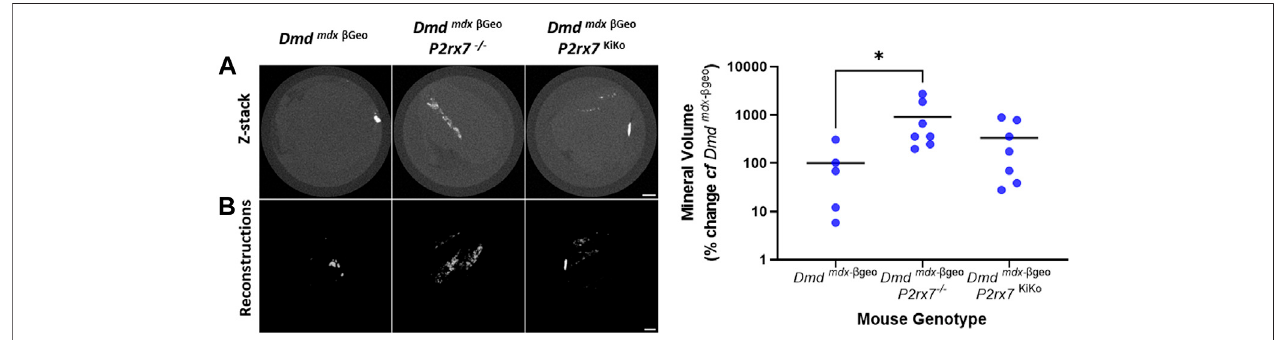
FIGURE3| Ectopicmineralisationin Dmd mdx- β Geo , Dmd mdx- β Geo P2rx7 − / − and Dmd mdx- β Geo P2rx7 KiKo quadriceps.Isolatedquadricepsmuscleswerescanned ex vivo by XCT and analysed in FIJI. (A) Z-stack images and 3D reconstructions from representative Dmd mdx- β Geo , Dmd mdx- β Geo P2rx7 − / − and Dmd mdx- β Geo P2rx7 KiKo quadriceps muscles. (B) . Quanti fi cation of mineralised volume within whole quadriceps muscles revealed increased mineralised volume in Dmd mdx- β Geo P2rx7 − /